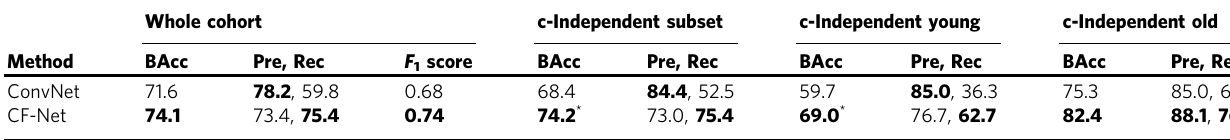
Fig. 2 The proposed confounder-free neural network (CF-Net). a Model architecture for confounder-free feature learning, composed of three subnetworks. FE learns features that successfully predict ( P ) the outcome y while being invariant (conditional independence de fi ned by ρ ) to the confounding variables with the help of the adversarial component CP . b The confounder c in fl uences both the output y (i.e., ② ) and the input X , from which feature F is extracted (i.e., ① ). The classi fi er deems to fi nd the relation ③ to enable prediction of the output labels. Our adversarial component aims to remove the direct dependency between F and c ① . Table 1 Balanced accuracy (%), precision (%), recall (%), and F 1 score of HIV-diagnosis prediction.